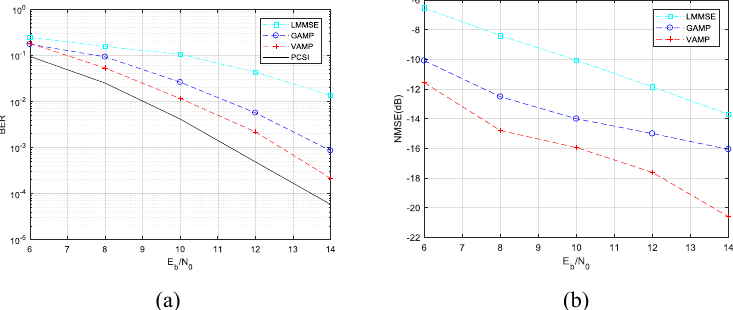
Fig. 4. ( a ) The change curve of BER with transmission. ( b ) The change curve of NMSE with UW